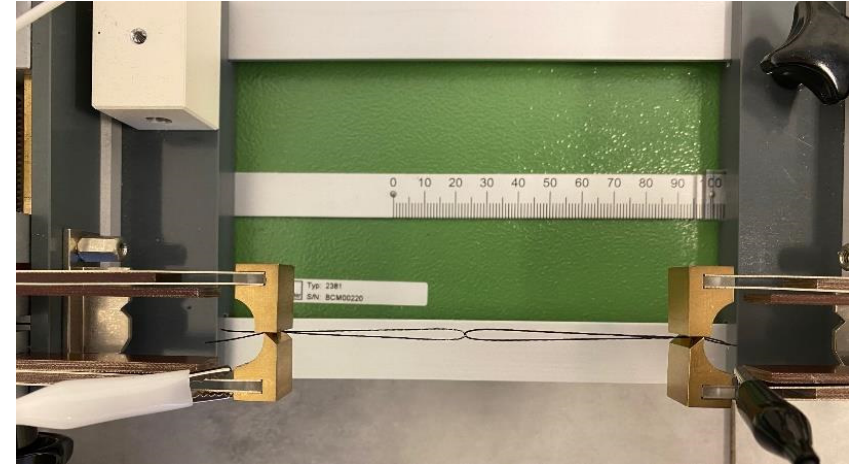
Figure 4. Image of the real measurement set-up of the interlooped sensory yarns.